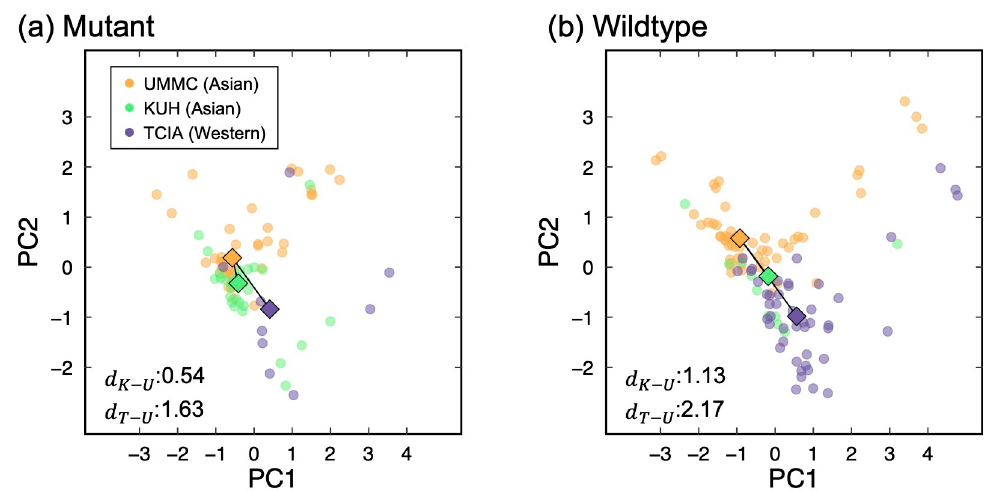
Fig 6. Distributions of signatures for (a) epidermal growth factor receptor mutants and (b) wildtypes among datasets from three countries. Euclidean distances between medians of the signatures from University of Malaya Medical Centre (UMMC) and The Cancer Imaging Archive (TCIA) ( d T − U ) were larger than that from UMMC and Kyushu University ). PC1 and PC2 represent first and second principal components, respectively, calculated among Hospital (KUH) ( d K − U constituent features in the signature. The medians were represented by square-shaped plots.